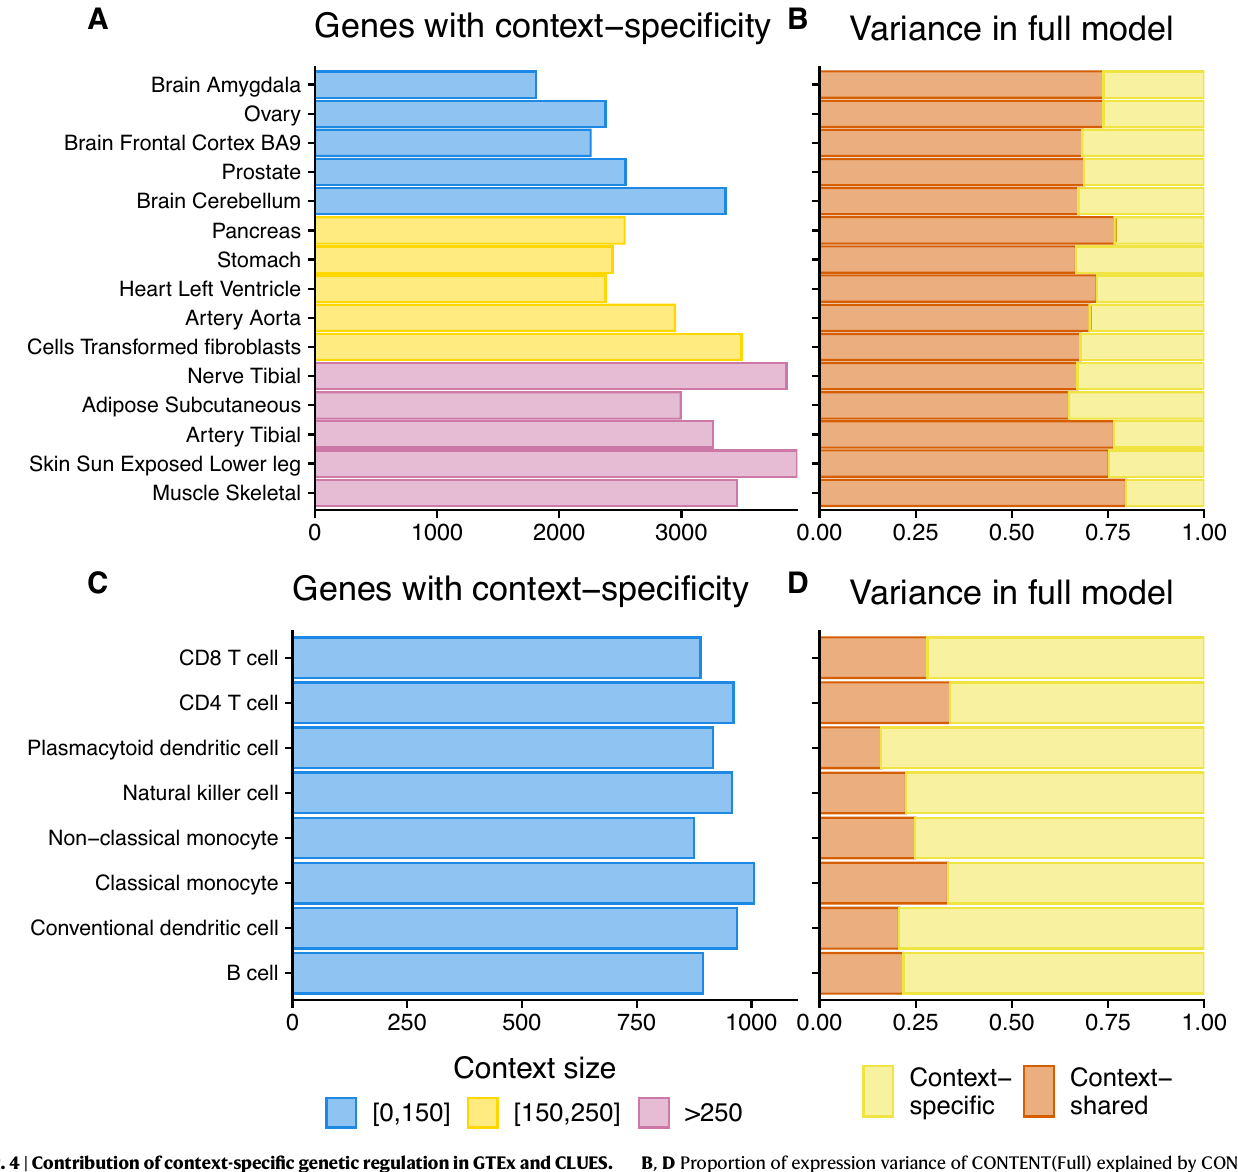
Fig.4 |Contributionofcontext-speci fi cgeneticregulationinGTExandCLUES. A , C Number of genes with a signi fi cant (FDR ≤ 5%) CONTENT(Speci fi c) model of expression in GTEx ( A ) and CLUES ( C ). Color indicates sample size of context.